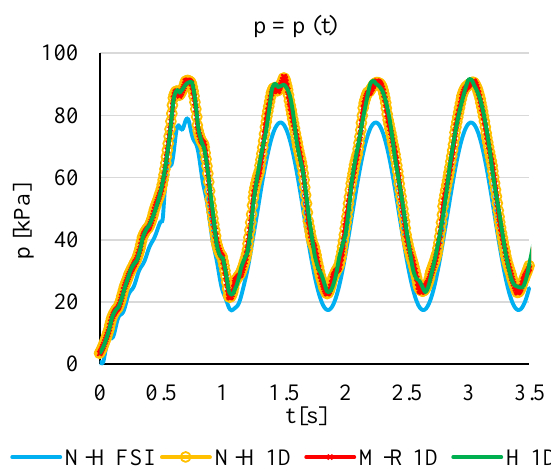
Fig. 12. Static pressures p in the thin-walled tube.